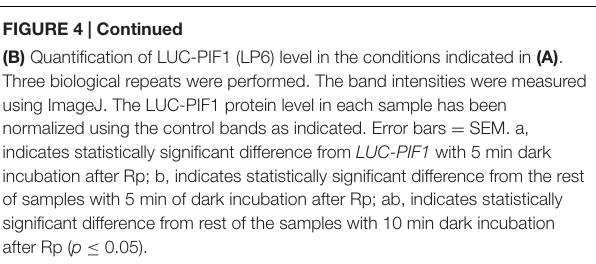
(B) Quantification of LUC-PIF1 (LP6) level in the conditions indicated in (A) . Three biological repeats were performed. The band intensities were measured using ImageJ. The LUC-PIF1 protein level in each sample has been normalized using the control bands as indicated. Error bars = SEM. a, indicates statistically significant difference from LUC-PIF1 with 5 min dark incubation after Rp; b, indicates statistically significant difference from the rest of samples with 5 min of dark incubation after Rp; ab, indicates statistically significant difference from rest of the samples with 10 min dark incubation after Rp ( p ≤